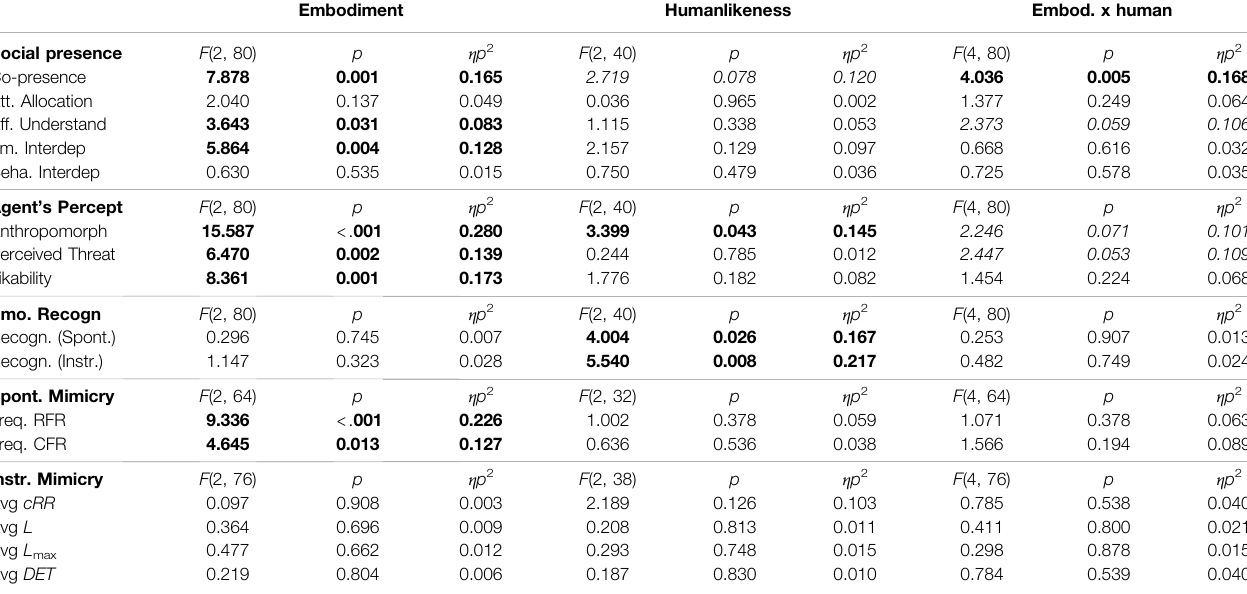
TABLE 2 | Results of 3x3 Mixed Measures ANOVAs for Manipulation checks and RQ1 and RQ2. The signi fi cant results are displayed in bold, while the trend effects are presented in italics. Embodiment